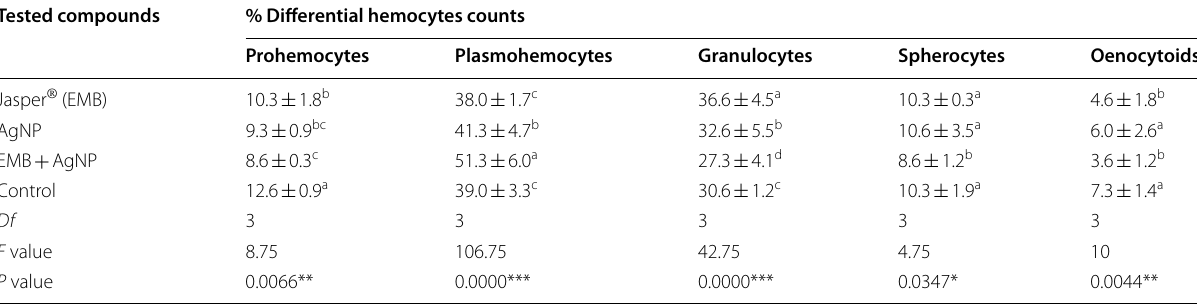
Table 6 Effect of tested compounds on the differential hemocytes counts (%) in the late sixth instar larvae of S. littoralis treated as fourth instar larvae Tested compounds